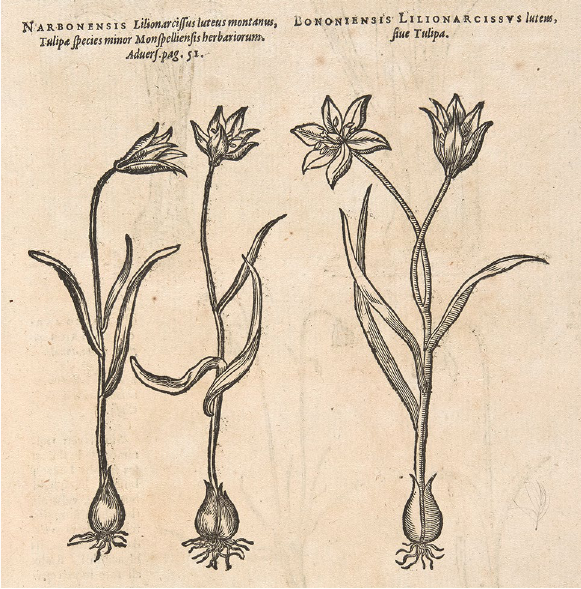
Figure 7. The Narbone (left) and Bologna (right) tulip. These woodcuts were reproduced many times in Plantin’s botanical publications. Here in Plantarum seu stirpium historia by Matthias de Lobel from 1576 (Special Collections, Wageningen University & Research – Library).